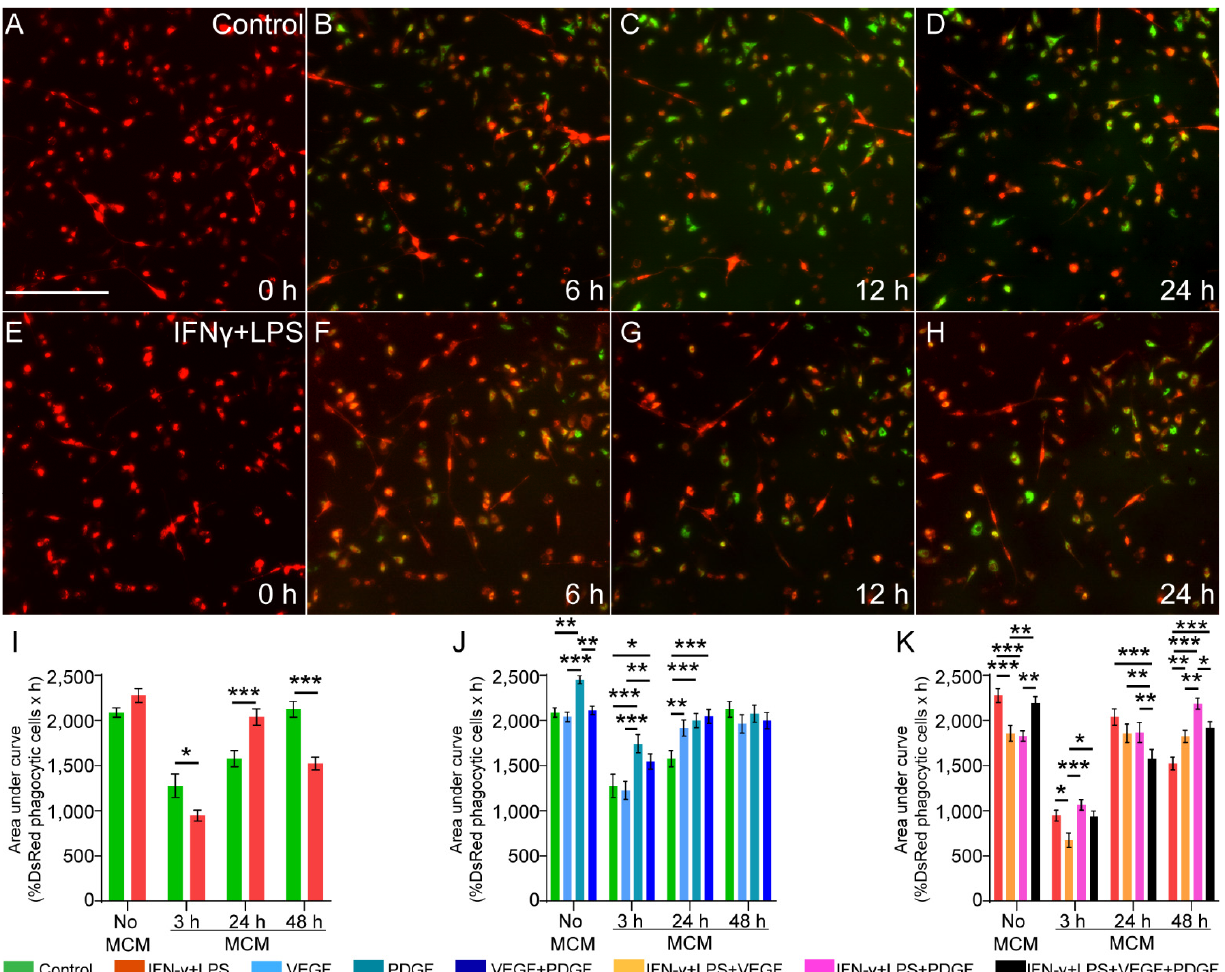
Figure 3. Effect of unconditioned and macrophage conditioned media (MCM) with or without VEGF, PDGF on phagocytosis of myelin debris by primary OECs. ( A – H ) Time lapse images of DsRed OECs (red) phagocytosing myelin debris (green) at 0, 6, 12 and 24 h. Shown are representative time-lapse images for OECs in the ( A – D ) absence and ( E , F ) presence of 3 h pro-inflammatory MCM. Scale bar: 200 μ m. ( I – K ) Graphs show area under curve (AUC) for phagocytosis of myelin debris with (3, 24, 48 h treated) or without MCM for ( I ) control and IFN γ + LPS, ( J ) control, VEGF, PDGF and combined VEGF + PDGF, ( K ) VEGF, PDGF and combined VEGF + PDGF in inflammatory media (IFN γ + LPS) . * p ≤ 0.05, ** p ≤ 0.01, *** p ≤ 0.001 measured using unpaired t -test for ( A ); two-way ANOVA